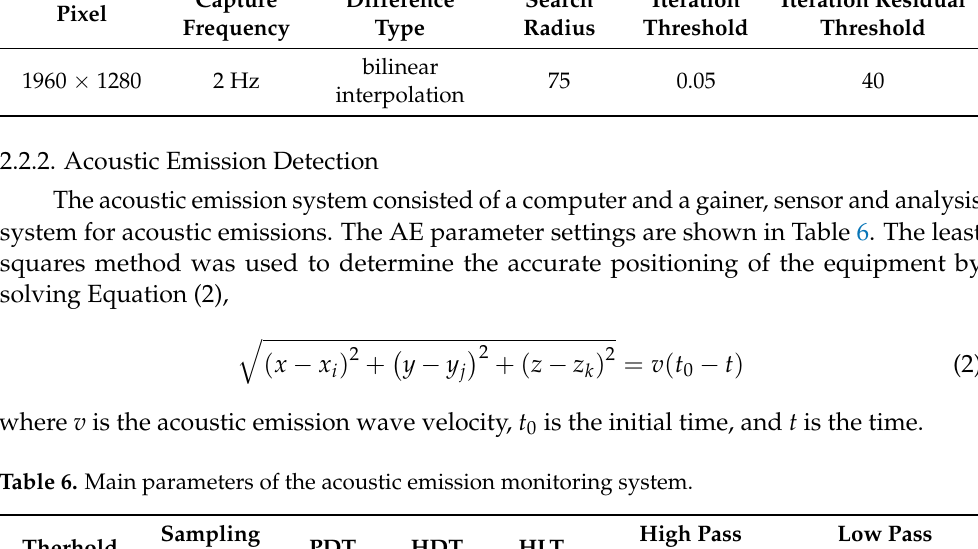
Table 6. Main parameters of the acoustic emission monitoring